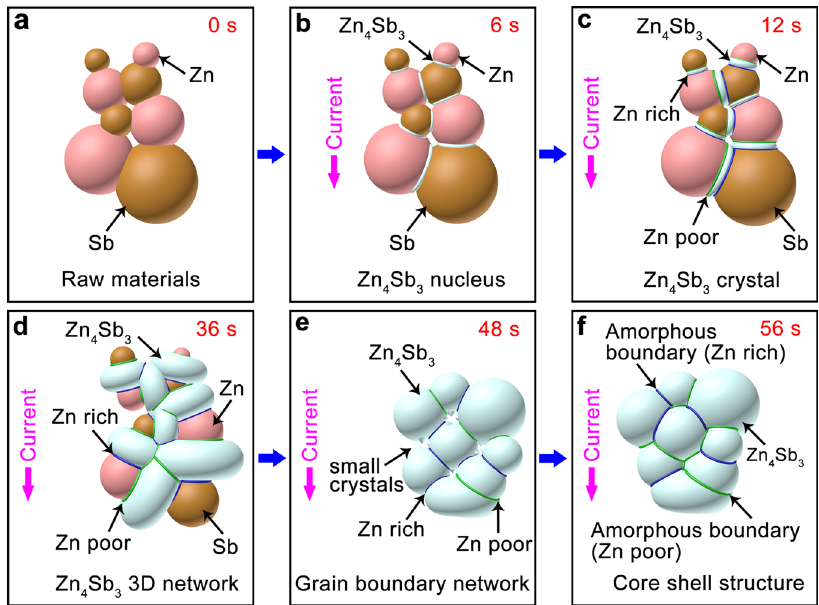
Fig. 3 Schematic diagram of the reaction mechanism. a Raw materials of Zn and Sb powders with stoichiometric ratio. b β -Zn 4 Sb 3 nuclei are formed at the contact point between Zn and Sb particles when the current is loaded (6 s). c β -Zn 4 Sb 3 crystal grows up gradually, and the composition in the upstream region of the current is poor in Zn, while the composition in the downstream region is rich in Zn (12 s). d β -Zn 4 Sb 3 3D network is formed as growing β -Zn fi lled with a large number of β -Zn 4 Sb 3 crystals contact each other (36 s). e Special grain boundary network structure 4 Sb 3 nanocrystals is formed due to the ion channel bulge. f Core-shell microstructure consisted of crystalline β -Zn 4 Sb 3 grains and amorphous off-stoichiometric Zn 4 Sb 3 grain boundaries that are formed when the current is